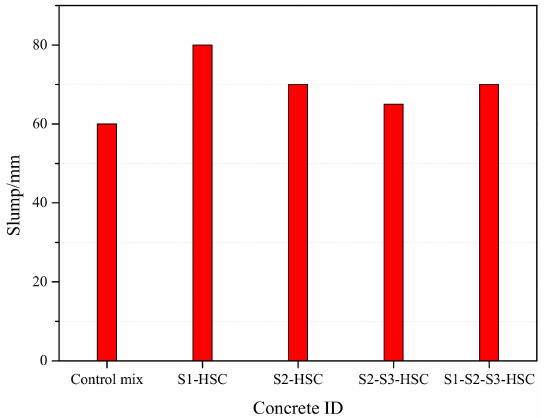
Figure 4. Slump of the